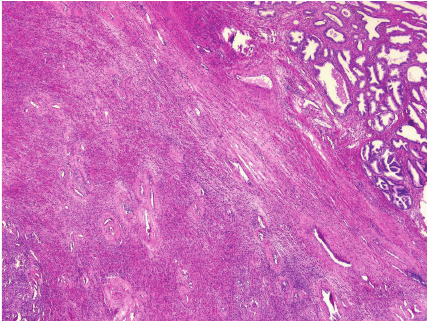
Figure 1: Low power view, showing the cellular spindle cell component and the hyaline vessels.